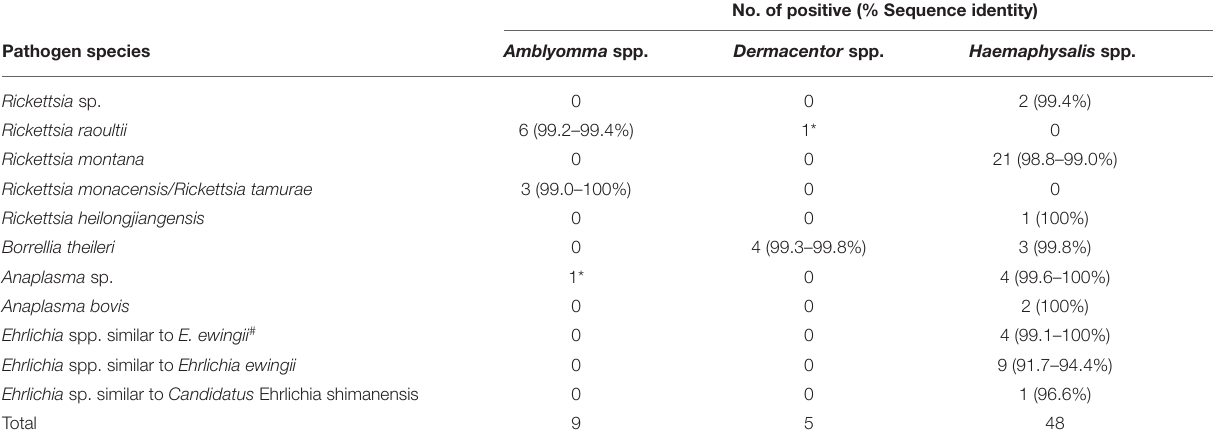
No. of positive (% Sequence identity)